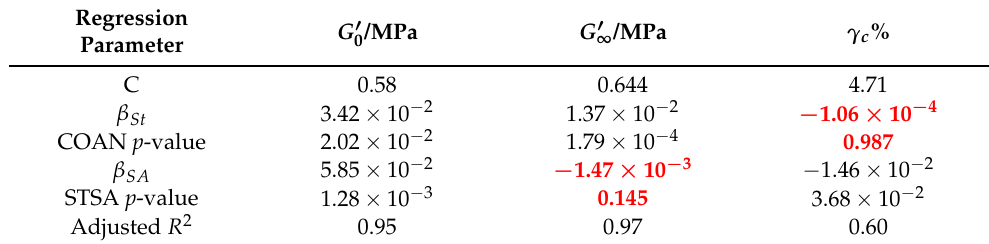
Table 8. Regression analysis of G (cid:48) fitting parameters. Regression